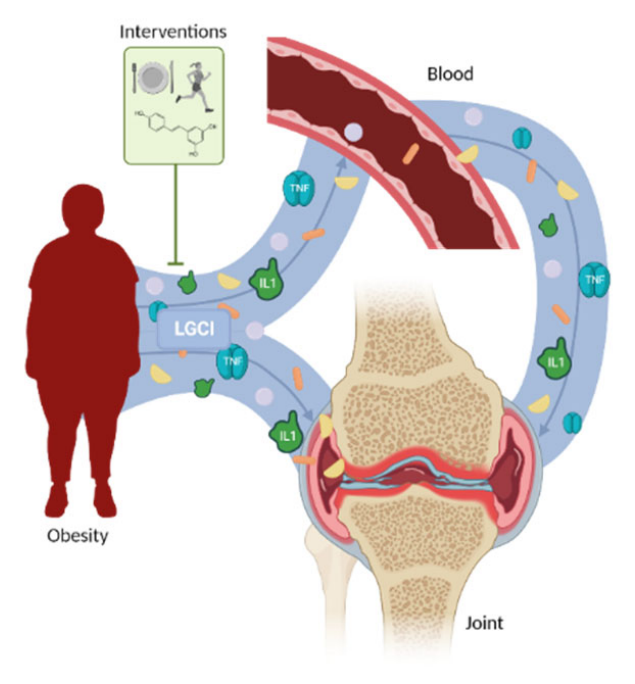
Figure 1. Relation between obesity-associated low-grade chronic inflammation and osteoarthritis. The proinflammatory molecules secreted systemically and locally by adipose tissue promote osteoarthritis instauration and progression. This effect could be modulated by pharmacological and non-pharmacological approaches.